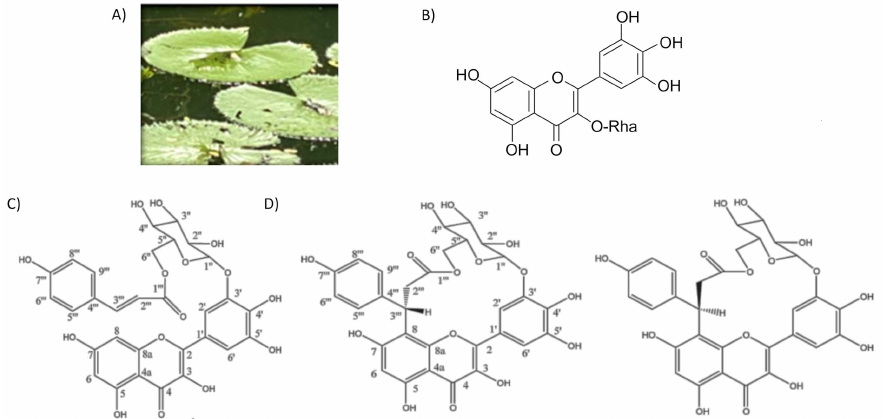
Figure 3. Chemical structures and names of the main antioxidant flavonoids from N. lotus leaf extracts. ( A ) N. lotus L. leaf morphology. ( B ) Chemical structure of myricetin-3- O -rhamnoside. ( C ) Chemical structure of myricetin-3 (cid:48) - O -(6 (cid:48) - p -coumaroyl) glucoside. ( D ) Chemical structure of the two macrocyclic flavonoids nympholide A and nympholide B. Picture by Duangjai